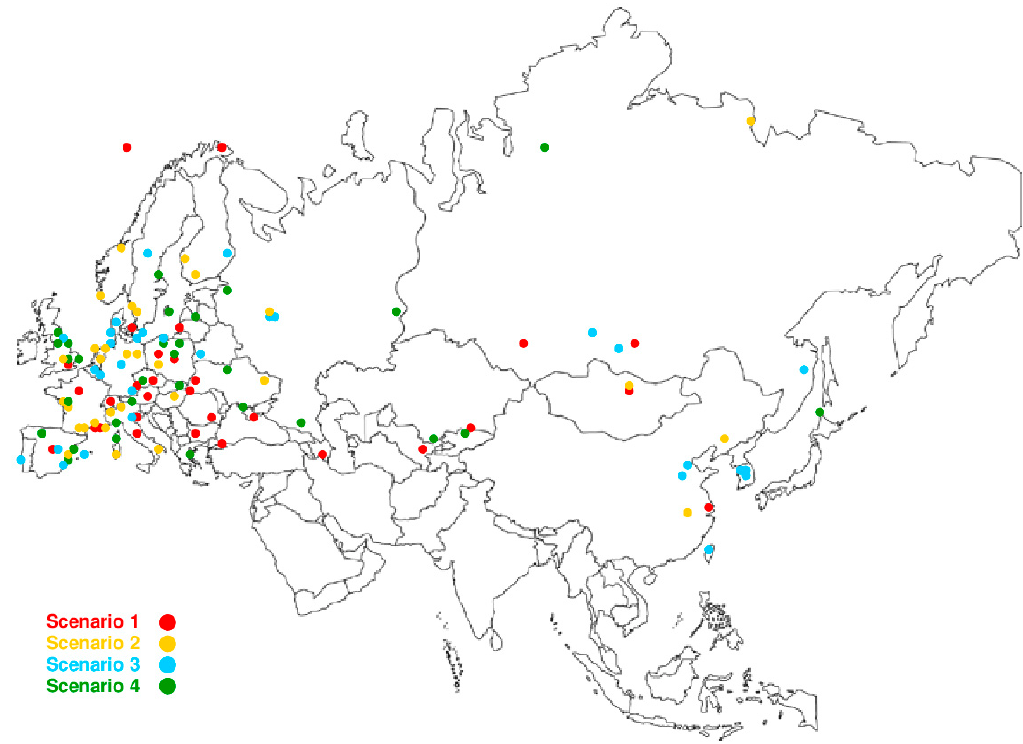
Figure 1. The location of the GNSS stations used in the four scenarios of the calculations.